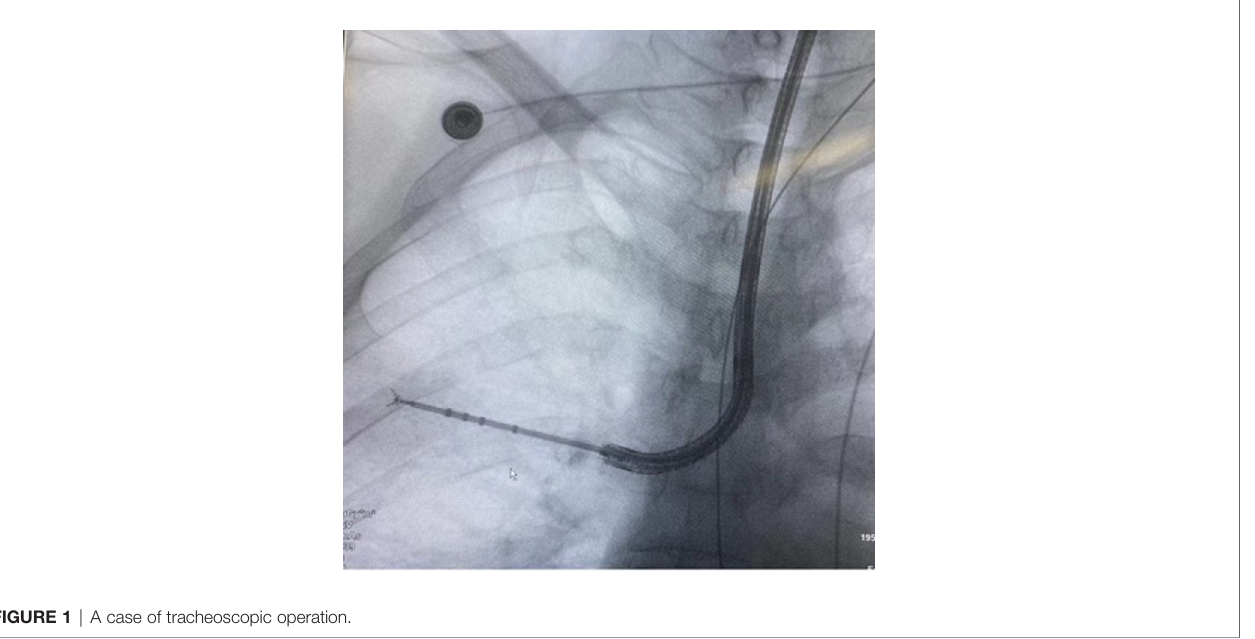
FIGURE 1 | A case of tracheoscopic operation.